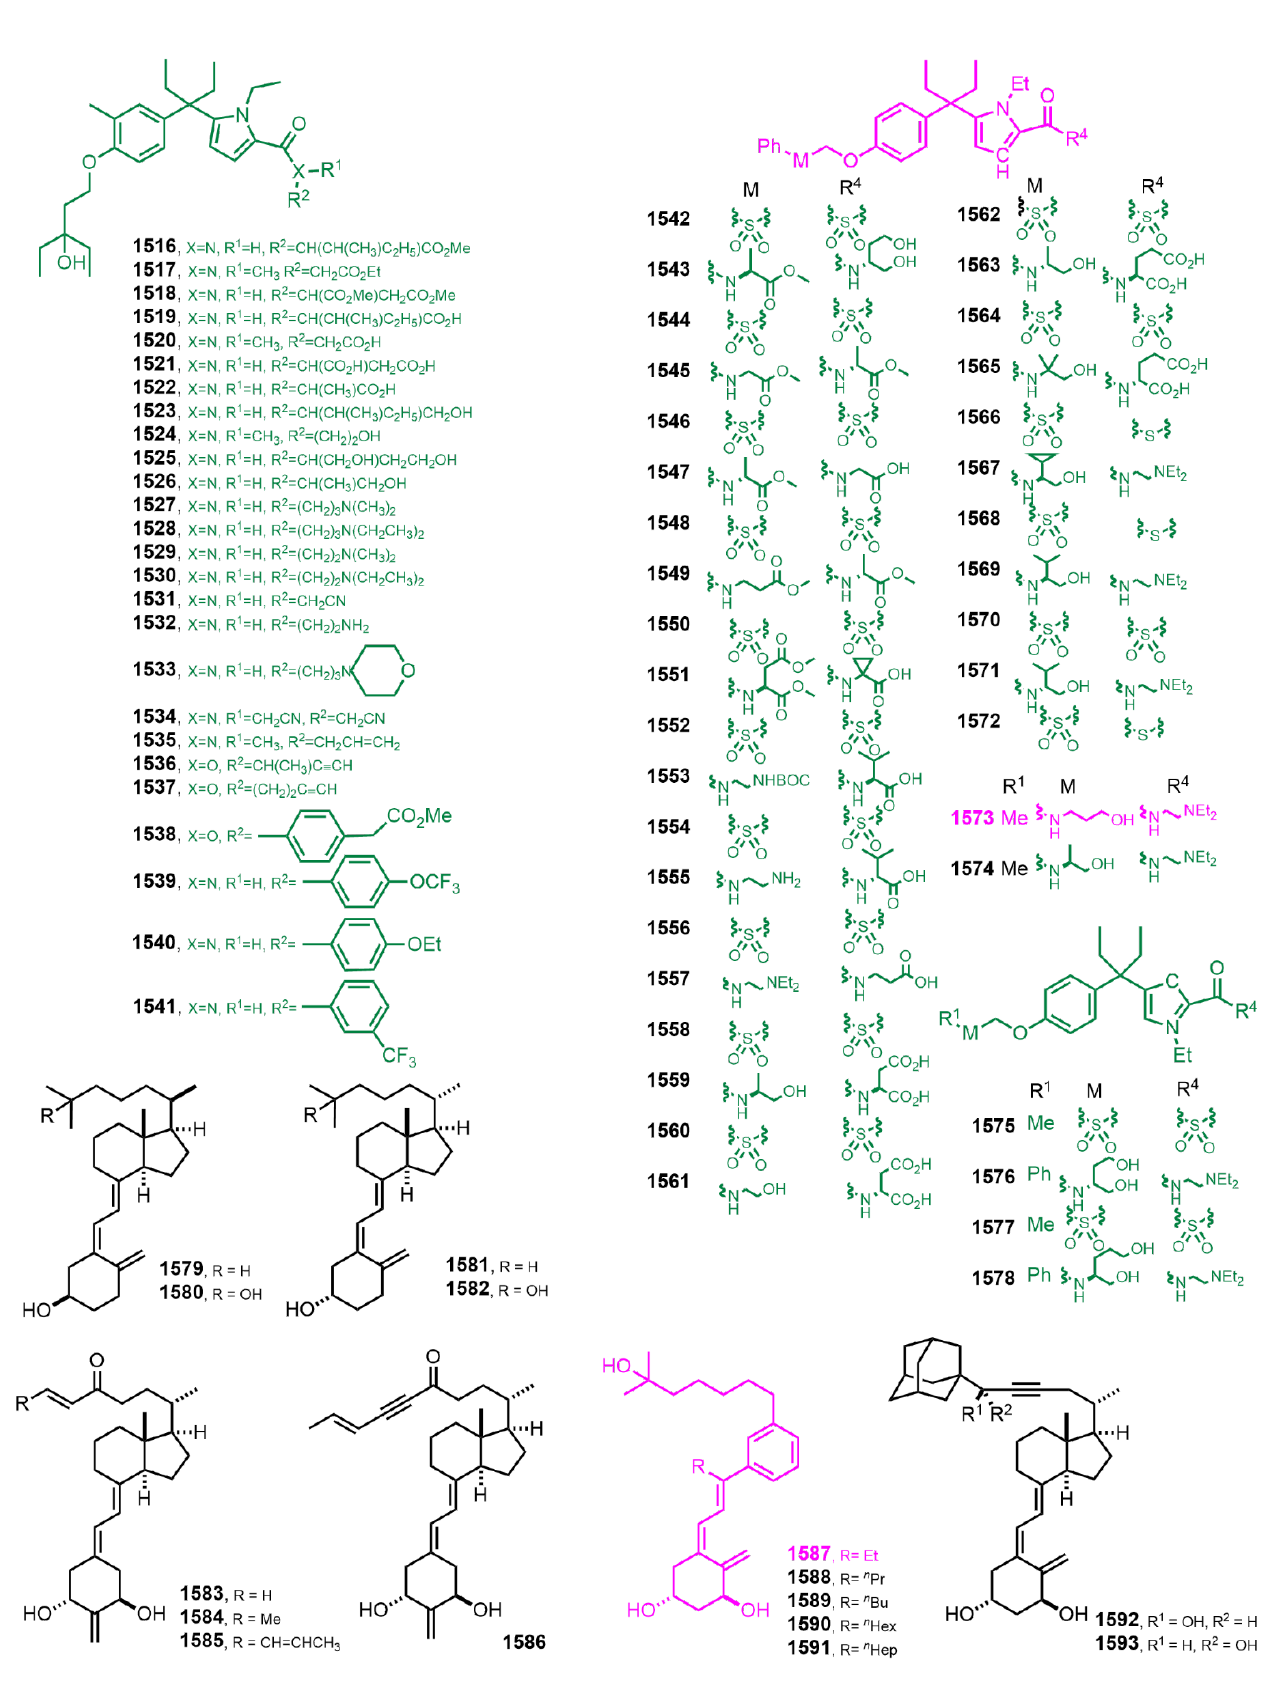
Figure 27. (2018) [359 – 364].